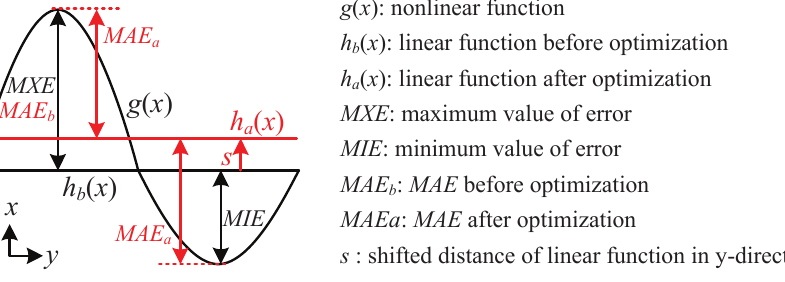
Figure 2. MAE is minimized by shifting the linear function in the y-direction.